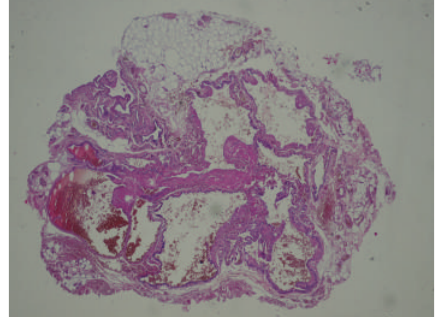
Figure 3: Tumour histology—dilated vascular areas.